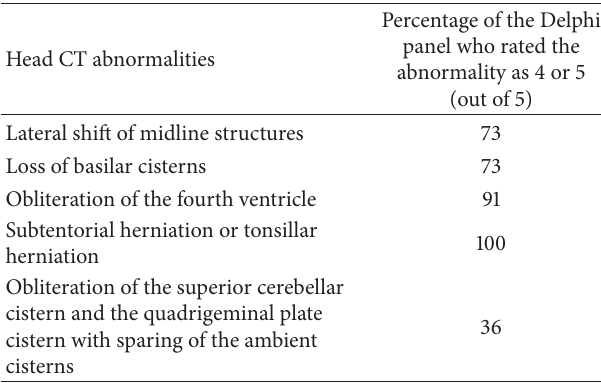
Table 1: Head CT abnormalities identified as contraindications to LP by the Delphi panel.